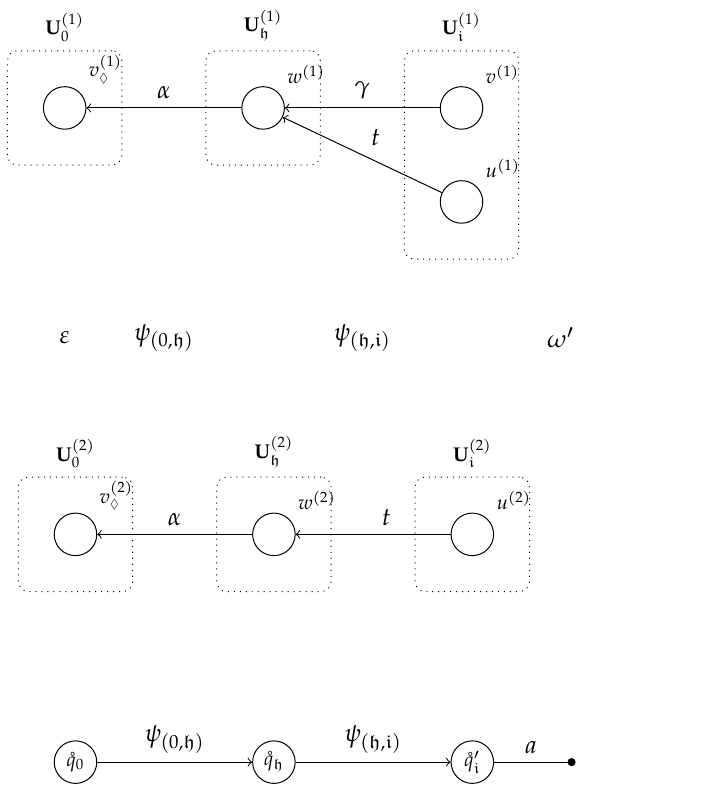
Figure 25. The relevant part of Γ p 1 q after the reduce action is performed by the character-level RNGLR and the corresponding part of Γ p 2 q after the shift action is performed by our